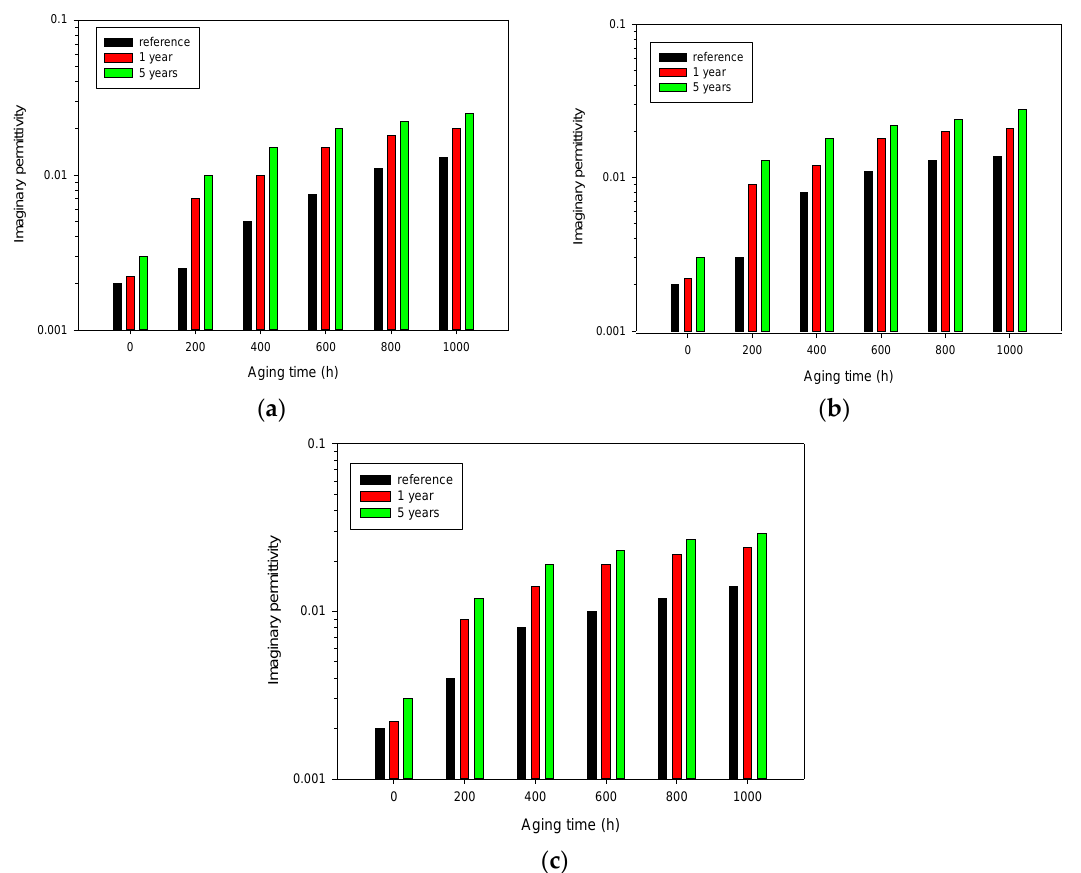
Figure 6. Imaginary permittivity at 100 kHz as a function of aging time at 0.42 kGy/h (a), 0.76 kGy/h (b), and 1.06 kGy/h (c), 85 ◦ C, measured immediately after aging (reference), after 1 year and 5 years of storage in ambient